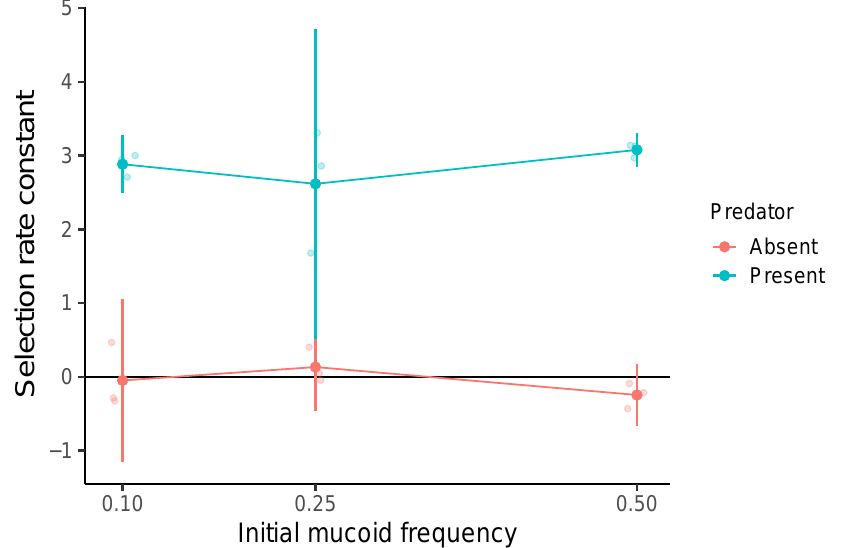
Figure 2. A mucoid clone outcompetes a non-mucoid clone only under predation pressure but does not exhibit negative frequency dependence. Estimates of the fitness of a mucoid clone isolated from ME4 at cycle 18 in competition relative to a contemporary non-mucoid clone (as represented by the selection-rate constant) across three initial frequencies are shown. x-axis values depict the estimated starting frequencies for the mucoid clone at the beginning of the experiment. Positive and negative values indicate estimates that the mucoid clone has higher or lower fitness than the non-mucoid clone, respectively. Smaller and larger dots represent individual-replicate and mean values, respectively. Error bars show 95% confidence intervals from three biological replicates ( t -distribution).